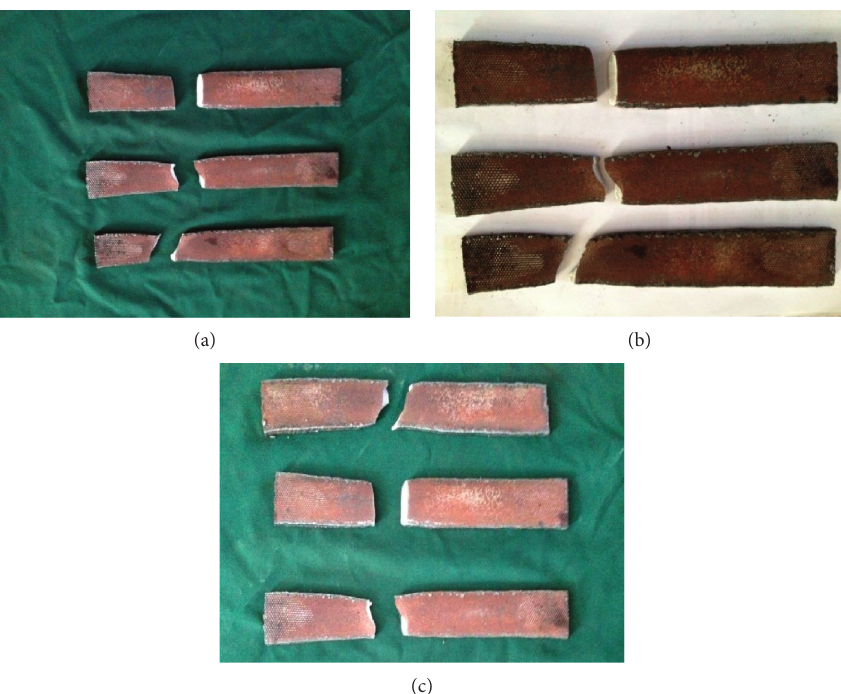
Figure 3: Photographs of steel specimens. (a) Outer pipe steel specimens. (b) Inner pipe steel specimens. (c) Base plate and ribbed plate steel